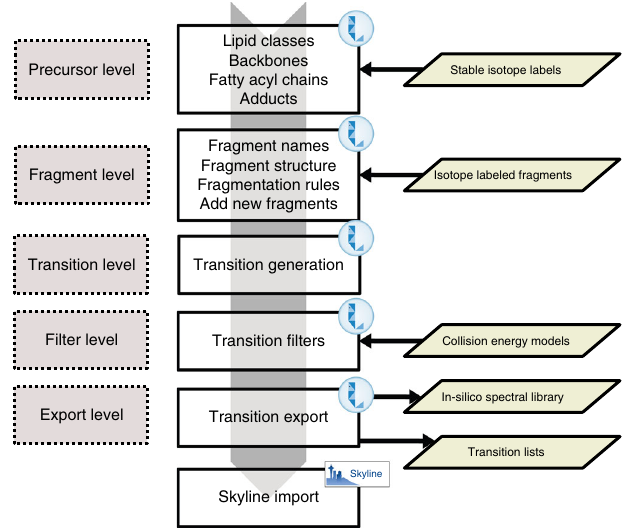
Fig. 2 LipidCreator system levels and fl ow of information. LipidCreator uses an internal knowledge base that stores information about lipids and their fragments. This information is assembled based on the user ’ s selection of lipid classes and additional parameters from the two main levels, the precursor and fragment level. Then, LipidCreator combines the user ’ s selection with information about lipid classes, precursors, backbones, fatty acyl chains, lipid fragments and information on isotope labels and forwards it to the transition layer for targeted assay generation. The downstream fi lter layer then applies collision-energy models to the generated transitions, if either automatic CE optimization or manual CE mode are enabled. The fi nal export layer generates the fi nal transition lists and spectral libraries and either stores them locally or transmits them directly to